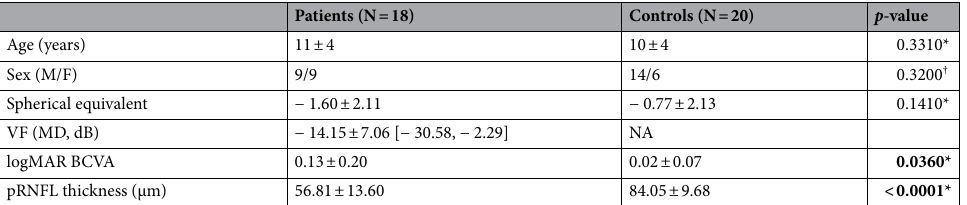
Table 1. Demographics of postoperative pediatric and juvenile craniopharyngioma patients and healthy controls. Significant values are indicated in bold. N numbers, dB decibel, VF visual field, MD mean